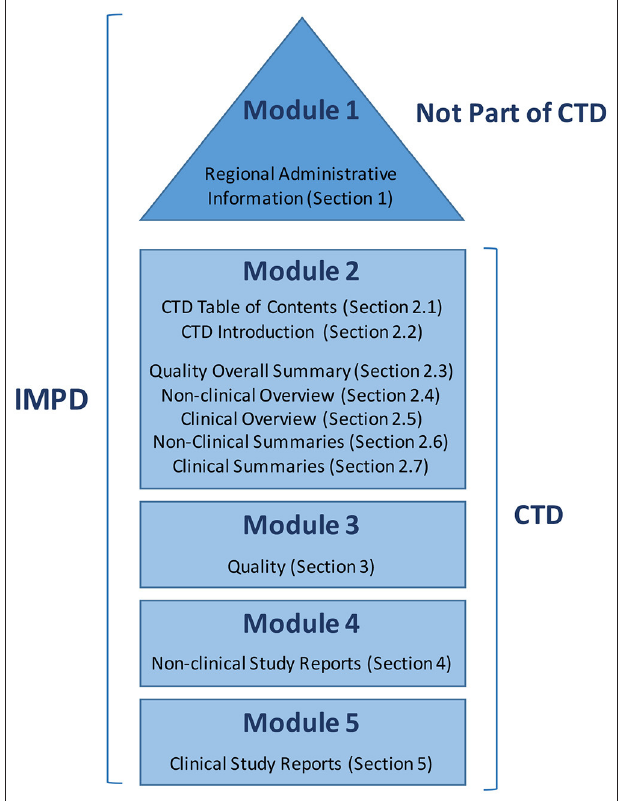
FIGURE 1 | Parts of the Investigational Medicinal Product Dossier (IMPD) as collected in the Notice to Applicants prepared by the European